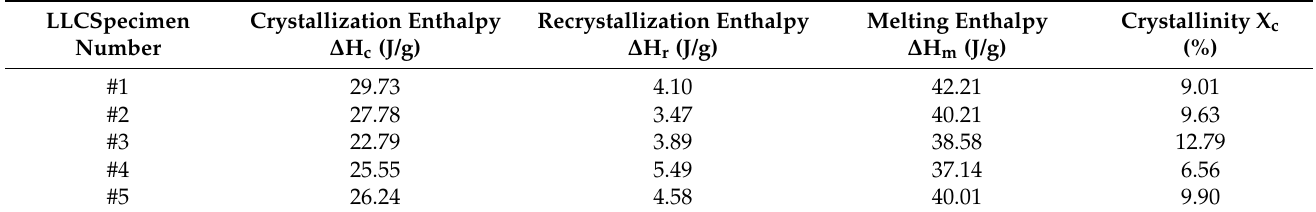
Table 3. Crystallinity contents reported for the five LLC scaffolds.